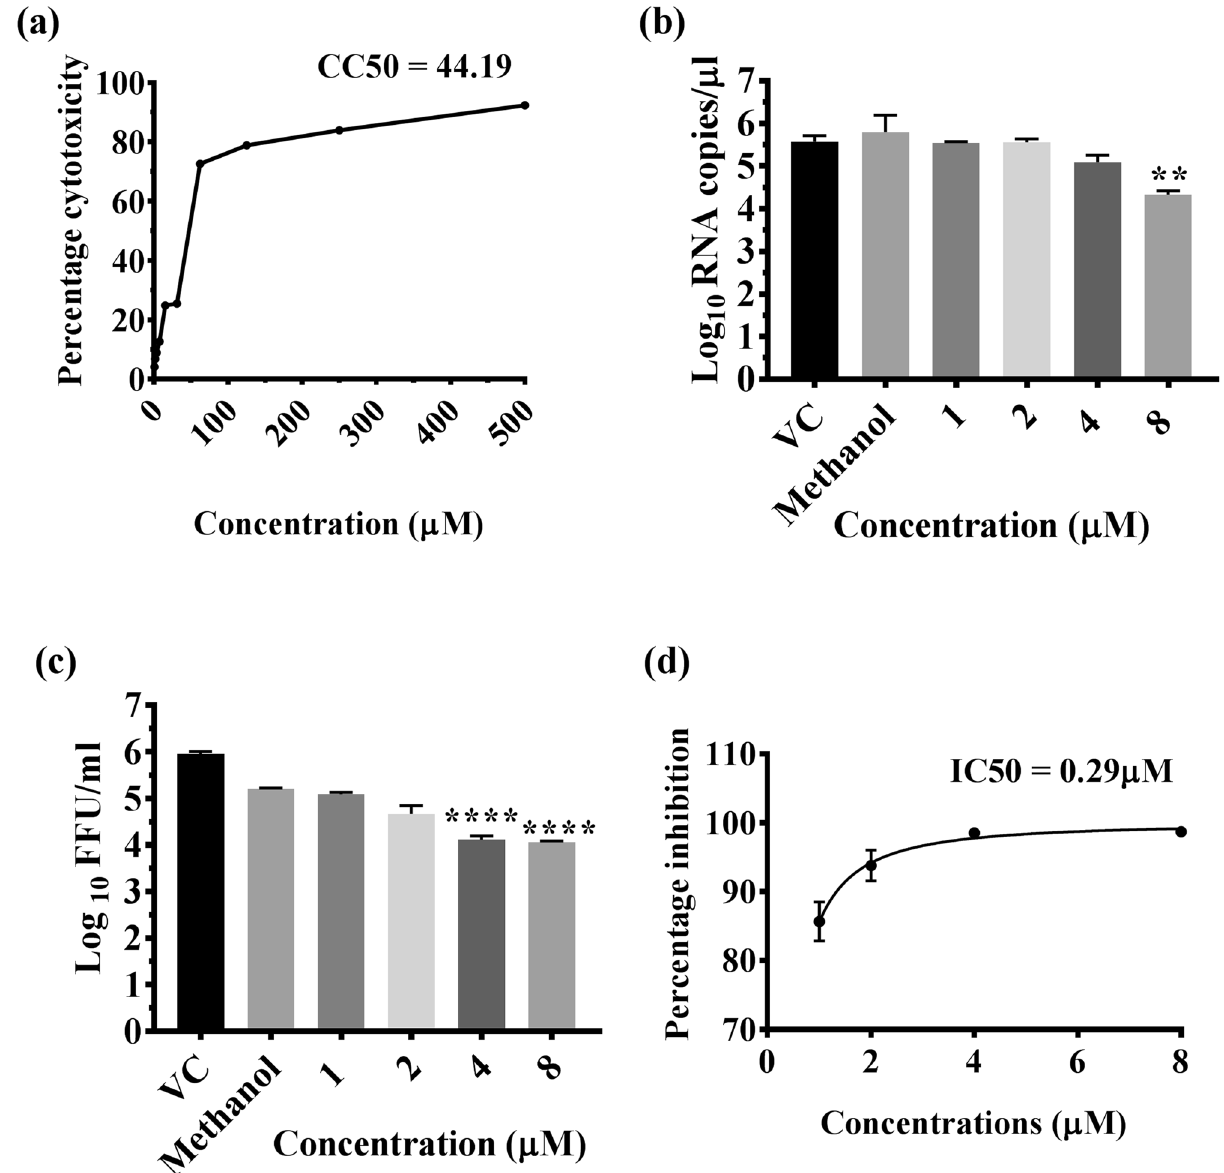
Figure 1. ( a ) Effect of Chebulinic acid (CA) on Vero E6 cells and dengue virus (DENV). ( a ) Cytotoxic effect of CA at various concentrations on Vero E6 cells. ( b , d ) Direct virucidal effect of CA at various concentrations on dengue virus infection at MOI = 0.1 in Vero E6 cells. Virus titer was assessed at 120 h post infection and expressed in terms of ( b ) Log 10 viral RNA copies/µL and ( c ) Log 10 focus forming units/ml, ***P value < 0.0001, *P < 0.05. ( d ) Percentage inhibition of DENV focus forming units/mL by CA compared to virus control (VC). All the experiments were performed in triplicates, and the data values are expressed as mean ± (V382, E383, P384, G385) and lysine residues (K291, K295, K305, K307, K310) present in the flexible hinge between EDIII and EDI; (iii) fusion peptide (residues 100–108 on EDII) 11 ; (iv) K1 β-hairpin loop (residues 268–280) 43 and (v) glycosylation sites 44 . The physical locations of these sites on the E protein homodimer have been depicted in Supplementary Information (SI) Fig. S1. The docking results were further analyzed to identify the interacting residues and the types of interactions, using the LigPlot software 45,46 (version 2.2) and visualized using the PyMOL software 47 (version 2.3.3). CA showed binding to three significant regions of E protein, report- edly involved in binding to the primary receptors, GAGs, DC-SIGN, mannose receptor 48 , and facilitating the fusion process. Blind docking revealed a pocket at the interface of the two subunits of the homodimer, formed between the distal end of EDII of chain-A and EDI and EDII of chain-B (Fig. 5b). In this pocket, CA made contact with EDI and EDII of chain B, primarily with the residues of the K1 β-hairpin loop; whereas the rest of the contact residues are contributed by EDII of chain A (Fig. 5b,c). This CA-E protein interaction is mediated by 14 hydrogen bonds and 5 hydrophobic interactions (SI, Table S1). The second pocket involved in CA binding is